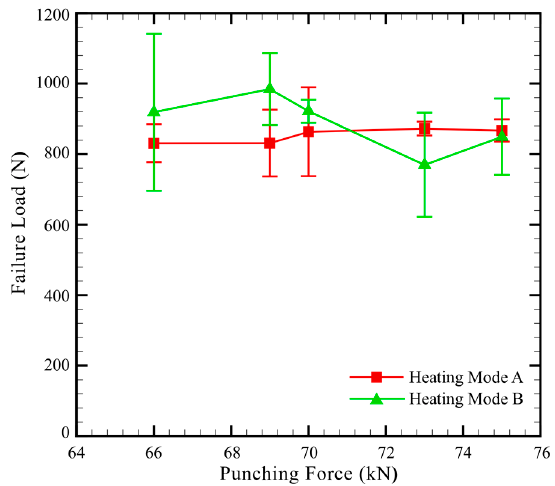
Figure 8. Failure load vs. punching force of dissimilar clinch joints in CT specimens made under Heating Modes A and B. The Punch P1, Die D1 and heating temperature of 100 °C are used.